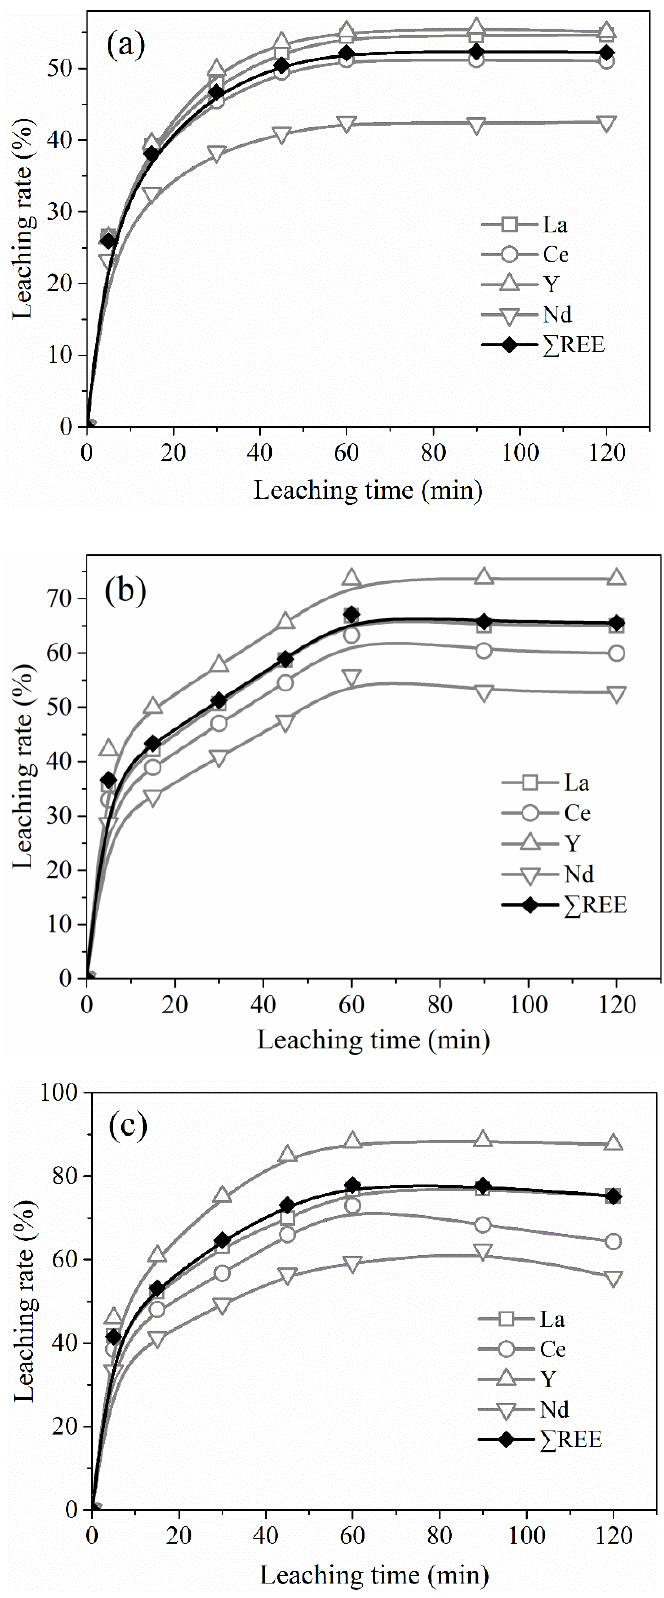
Figure 10. Leaching recoveries of REEs at different leaching temperatures (( a ), 30 ◦ C; ( b ), 60 ◦ C; ( c ), 80 ◦ C) as a function of leaching time under the conditions of 1.65 mol/L HCl and S/L ratio of 1/10.